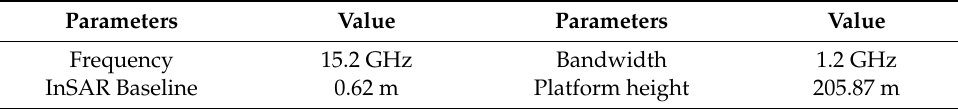
Figure 3. Illustration of the Unmanned Aerial Vehicle (UAV)-borne Polarimetric Interferometric Synthetic Aperture Radar (PolInSAR). Table 1. Parameters of the UAV